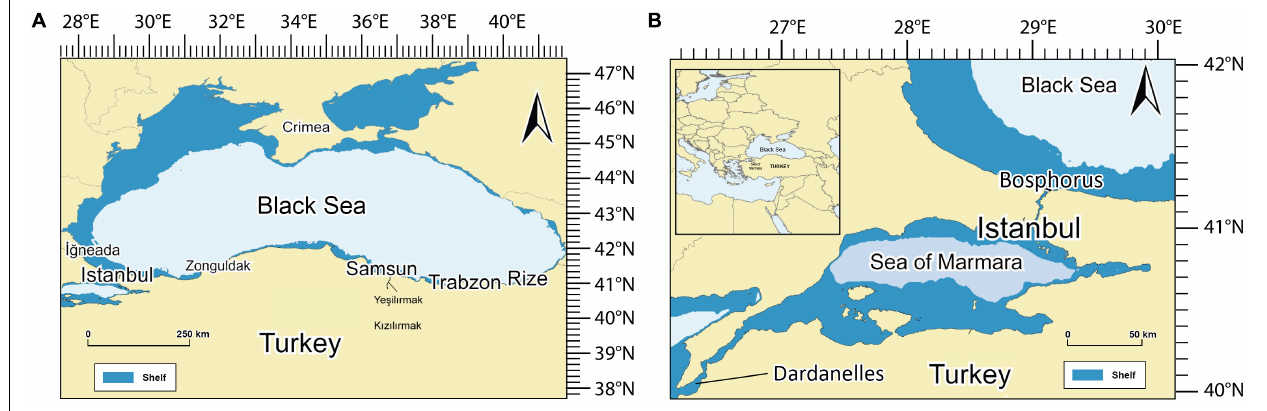
FIGURE 1 | (A) Black Sea and (B) the Sea of Marmara with the Bosphorus and Istanbul in the Northeast and the Dardanelles Strait in the Southwest, also displaying some cities and rivers mentioned in the text, with latitude and longitude.